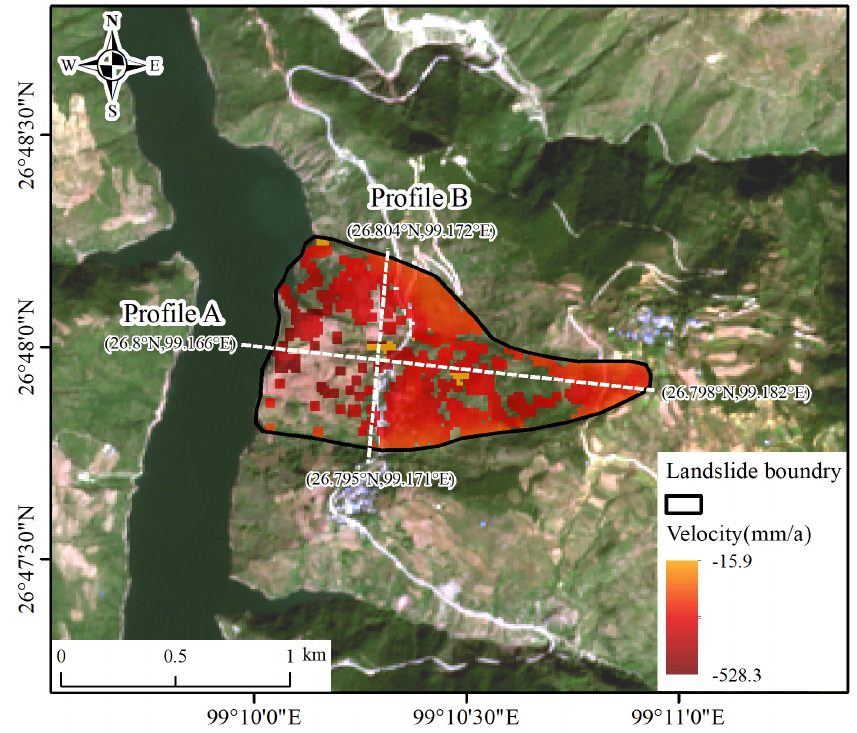
Figure 8. Deformation rate and interpretation boundary of the Cheyiping landslide. Two white dotted lines represent the lines of profiles, which are labeled with start and end